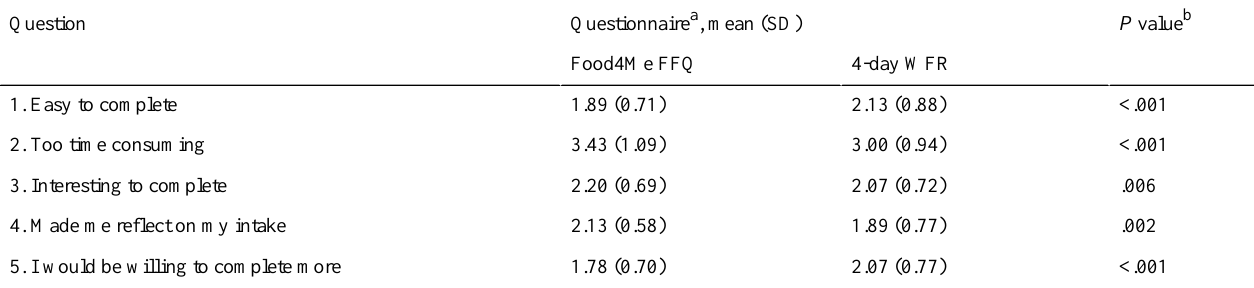
Table 8. Responses to Dietary Record Usability-Rating Questionnaire